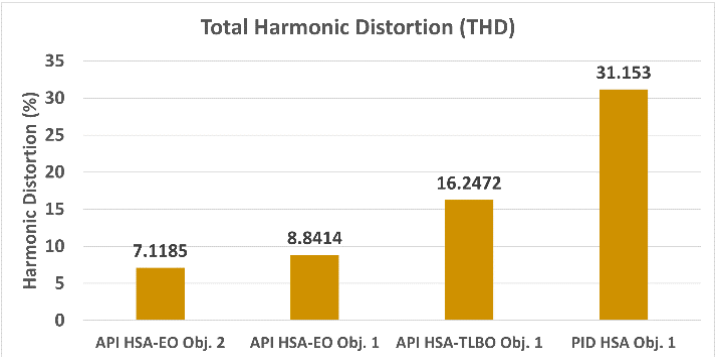
Figure 14. Total harmonic distortion ( THD ) percentage of the four controllers under normal opera- tion.